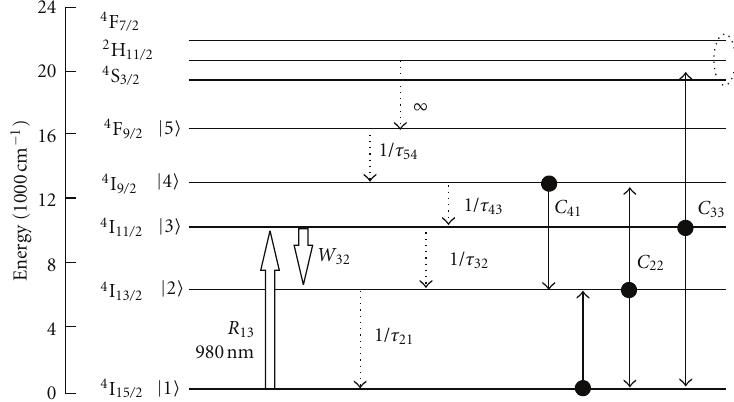
Figure 2: Diagram of energy